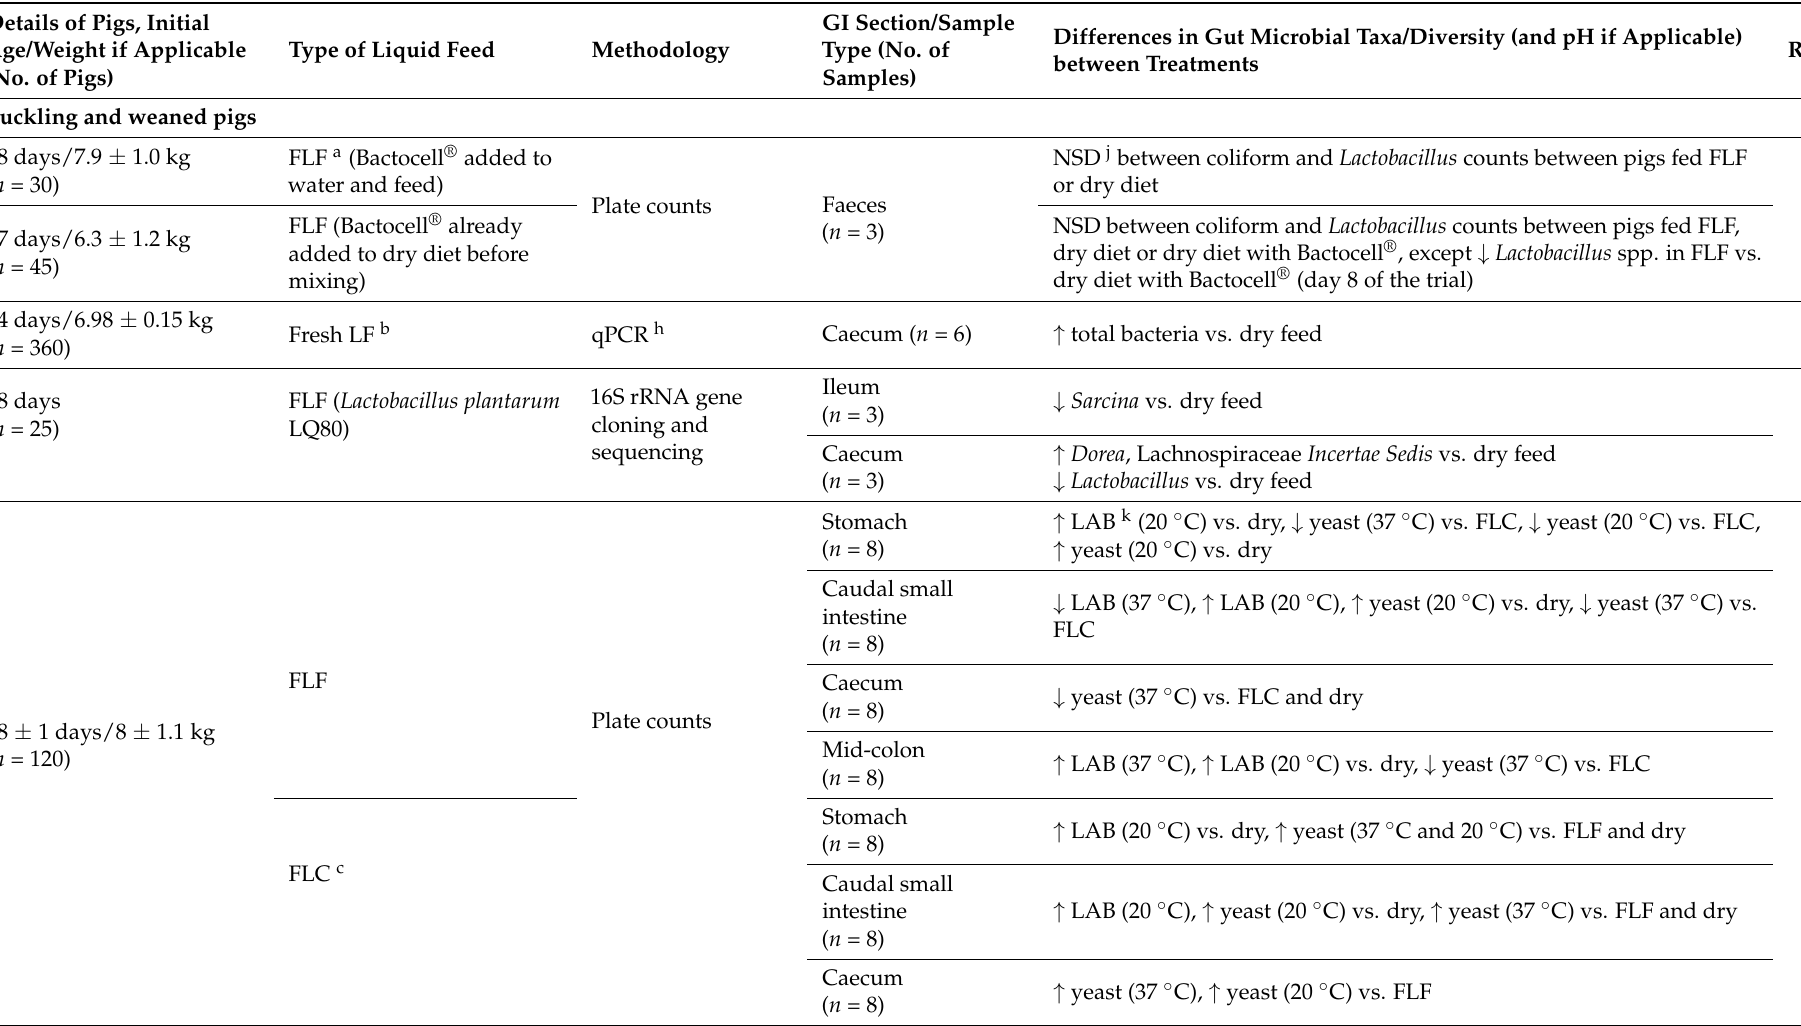
Table 8. The impact of feeding fresh, fermented, cereal fraction only fermented, soaked and enzyme-supplemented liquid feed on the gut microbiota of suckling, weaned and grow-finishing pigs. Details of Pigs,